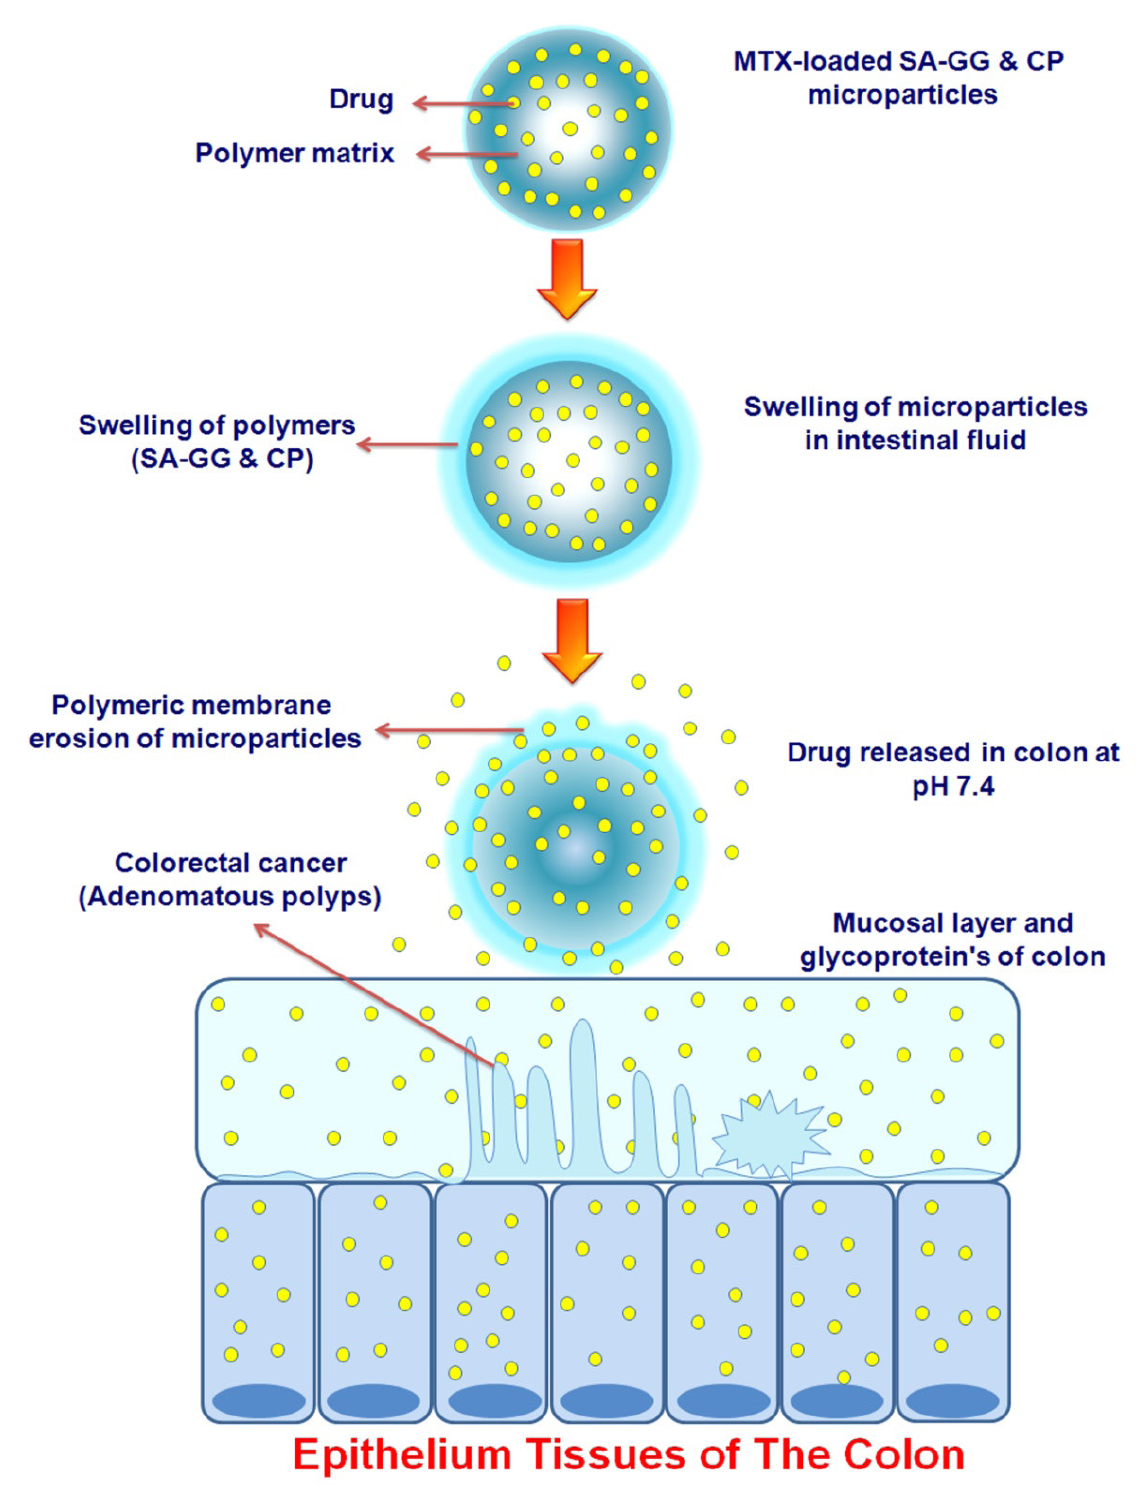
FIGURE 6 – Schematic of MTX loaded mucoadhesive microparticles for the treatment of colorectal